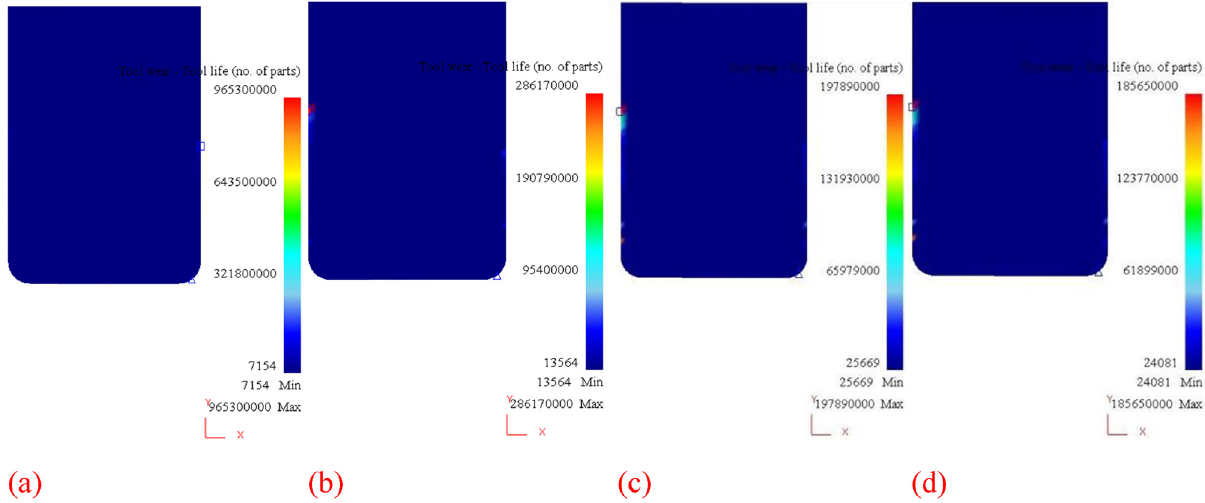
Figure 13: The simulated lifetime of ( a ) W 6 Mo 5 Cr 4 V 2 substrates die, ( b ) TiN coating die, ( c ) TiAlN coating die, and ( d ) TiAlCrN coating